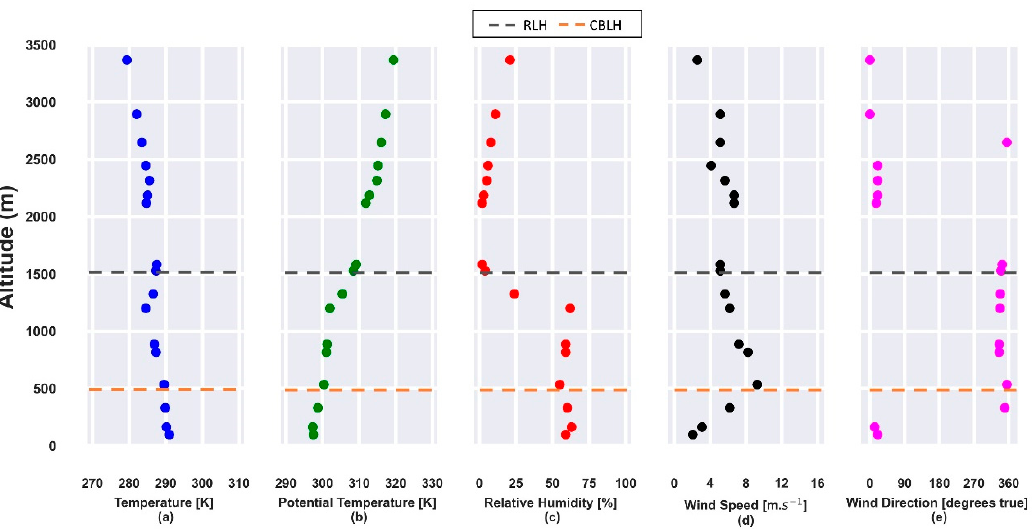
Figure 5. Atmospheric parameters obtained from radiosonde data on 23 July 2019 at 12:00 UTC. ( a ) Temperature [K]; ( b ) potential temperature [K]; ( c ) relative humidity [%]; ( d ) horizontal wind speed [m·s − 1 ]; ( e ) wind direction [degrees true]. The gray and orange dashed lines represent the RLH and CBLH, respectively.